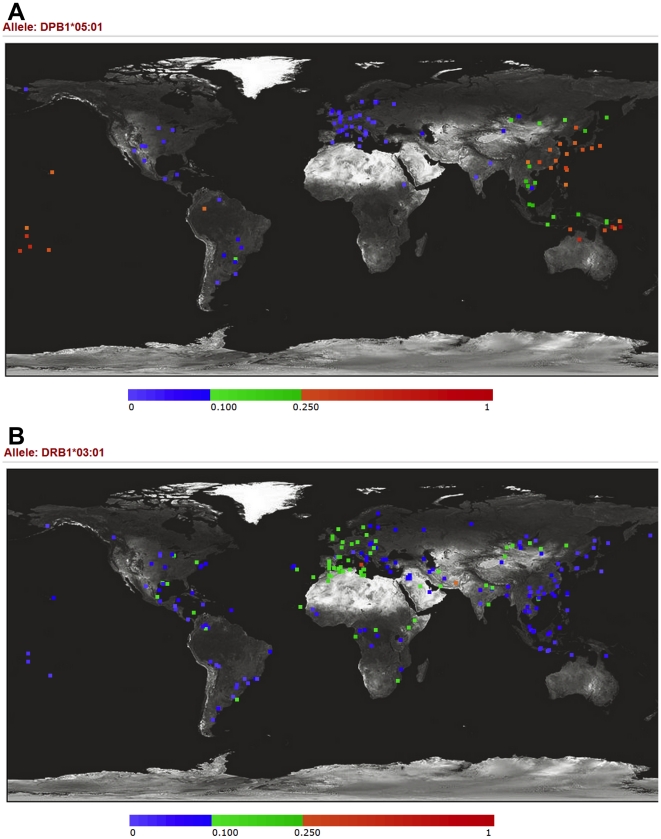
Allele frequency variations of HLA-DPB1*05:01 and HLA-DRB1*03:01 across worldwide populations.The allele frequencies (×100%) are presented with different colors, shown as the color bar below the figure. (A) HLA-DPB1*05:01, the major GD susceptibility allele we demonstrated, is much more prevalent in Asians than in Caucasians. (B) HLA-DRB1*03:01, the major GD susceptibility allele in Caucasians, has low frequencies in Asians. The data were screenshots from New Allele Frequency Database: http://www.allelefrequencies.net
[33] with permission.